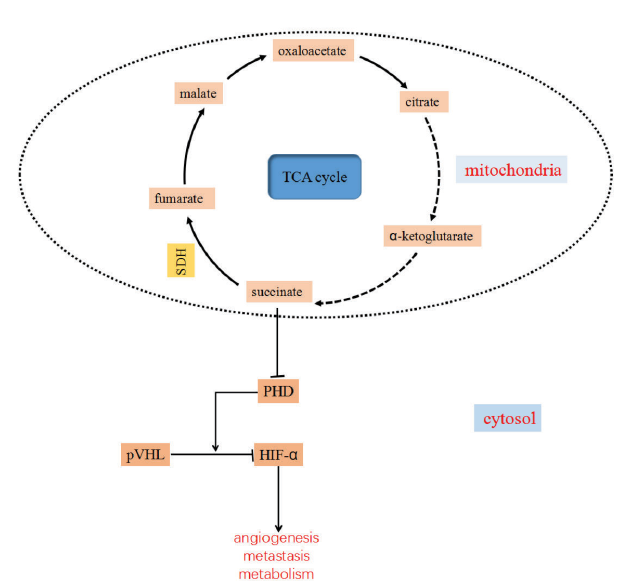
FIGURE 4 - A schematic model that summarizes the role of succinate in the mitochondrion-to-cytosol signaling pathway. Succinate accumulated in the mitochondria due to SDH inhibition is transported to the cytosol. Elevated cytosolic succinate inhibits PHD and thereby HIF-α hydroxylation. Consequently, pVHL binding to HIF-α is decreased, and elevated HIF activity induces expression of genes that facilitate angiogenesis, metastasis, and metabolism, leading to more aggressive tumors (Table